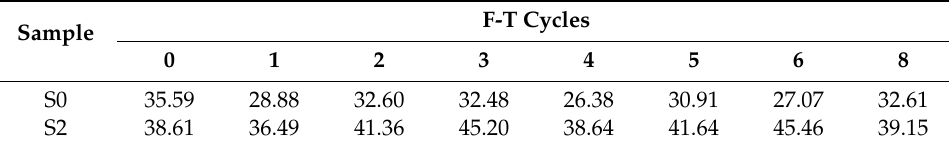
Table 3. D p under F-T cycles ( μ m).